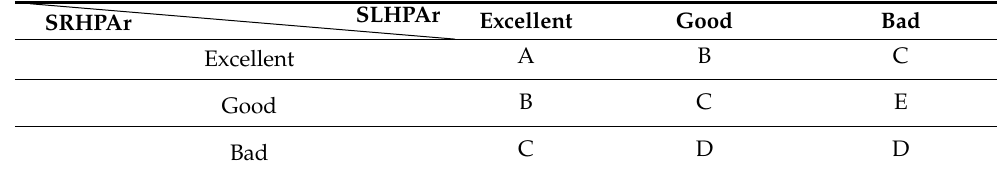
Table 4. Rule set—second-level fuzzy logic evaluation.